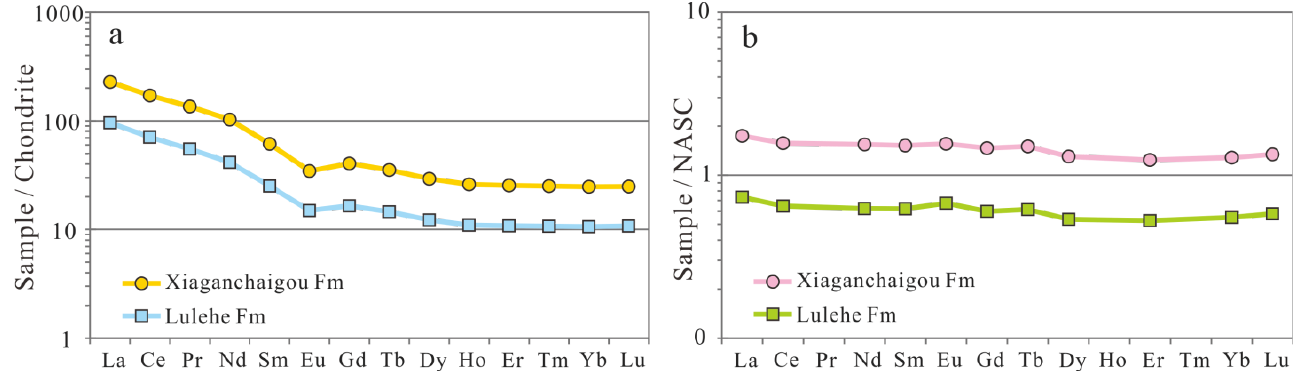
Figure 7. Chondrite-normalized REE patterns ( a ) and NASC-normalized REE patterns ( b ) of sand- stones from the Eocene in the Pingtai area .